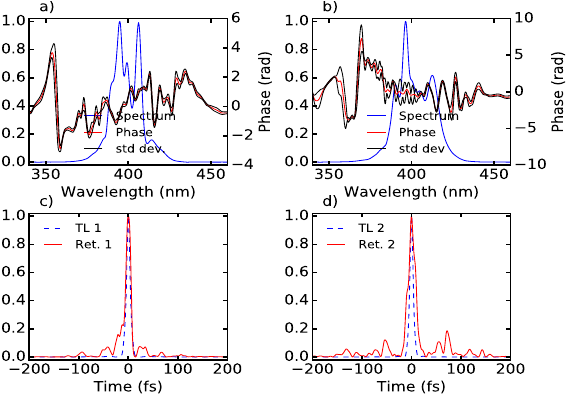
Fig. 3. (a) and (b) Spectrum and retrieved spectral phase for pulse 1 and pulse 2. (c) and (d) Pulse